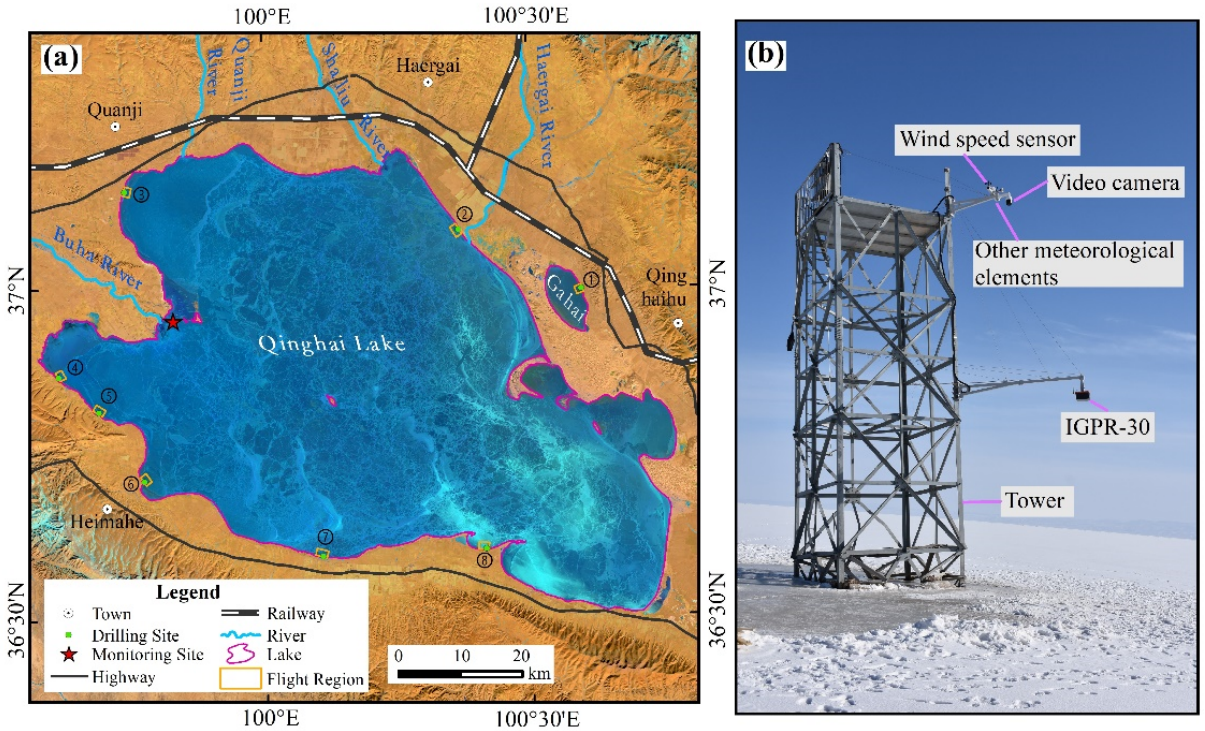
Figure 1. The location ( a ) and photo ( b ) of the GPR ice monitoring system setup (the base map is a Landsat OLI image acquired on 1 February 2021).